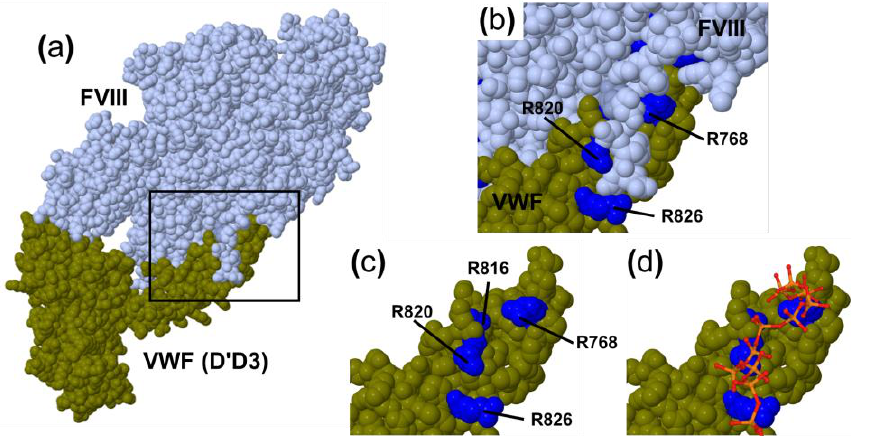
Figure 7. Predicted interaction of polyP with VWF. ( a ) The most recent structure of the FVIII–VWF complex (D′D3 domain), from reference [24] (PDB code 7KWO). The square indicates the area zoomed in on in the other panels of this figure. ( b ) Interaction between the FVIII-a3 acidic peptide and the VWF-highly basic groove. Arginines are labelled in blue. ( c ) VWF-highly basic groove without FVIII. ( d ) PolyP was superposed with the VWF highly basic groove. The model for polyP was extracted from the PDB (code 5LLF). Images were created using Mol* [25].